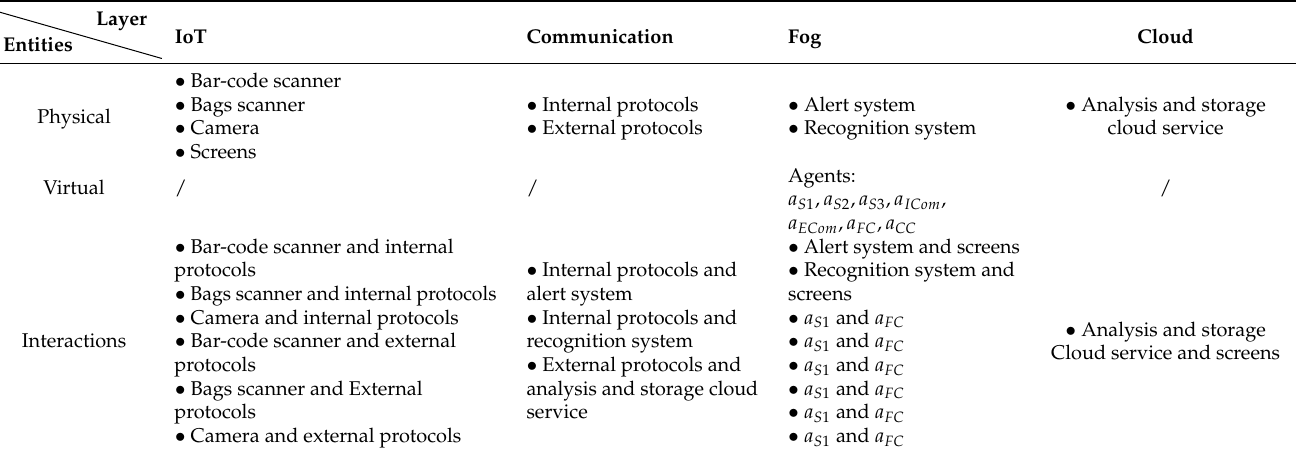
Table 1. CLA 4 Fog for